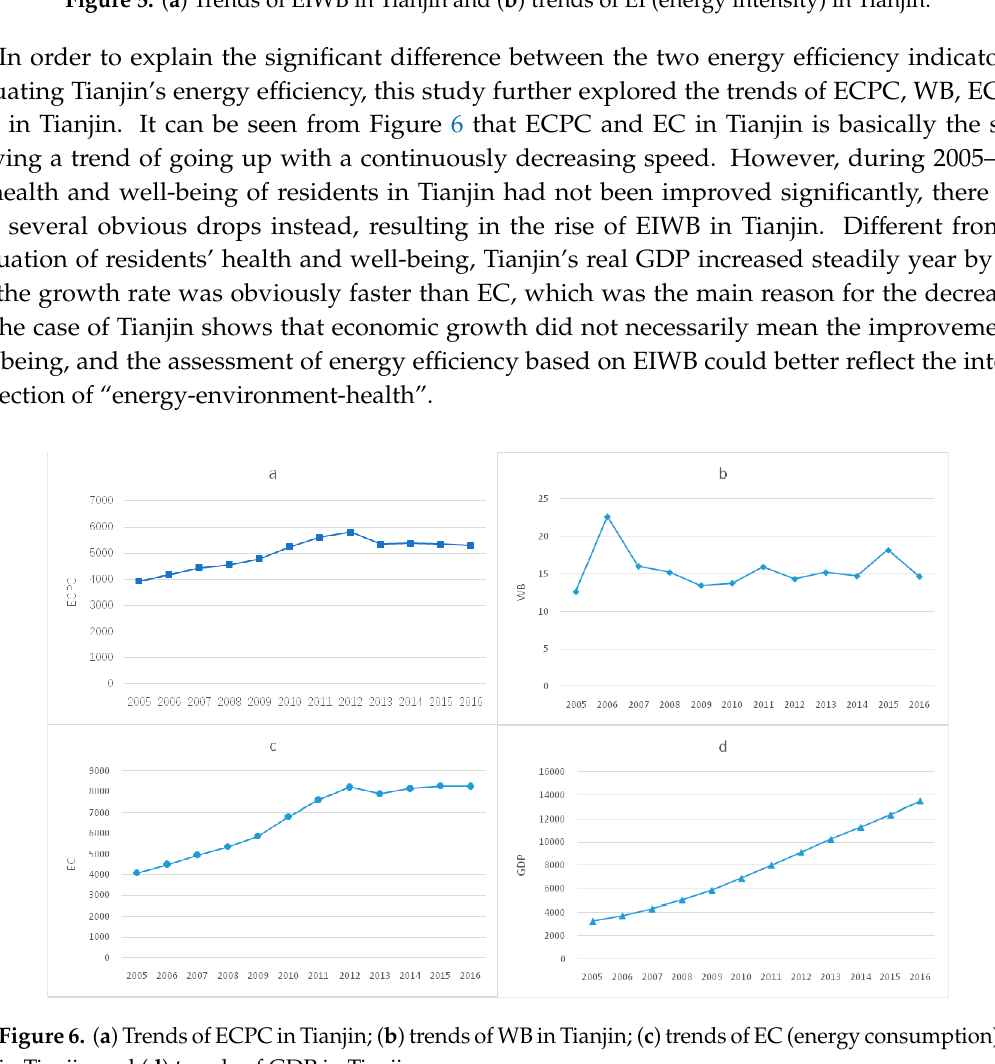
Figure 5. ( a ) Trends of EIWB in Tianjin and ( b ) trends of EI (energy intensity) in Tianjin.